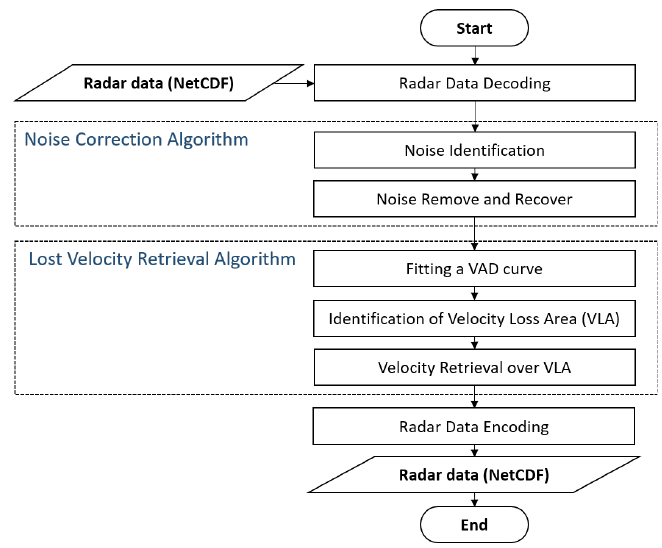
Figure 3. Flowchart for a quality control algorithm for radial velocity.